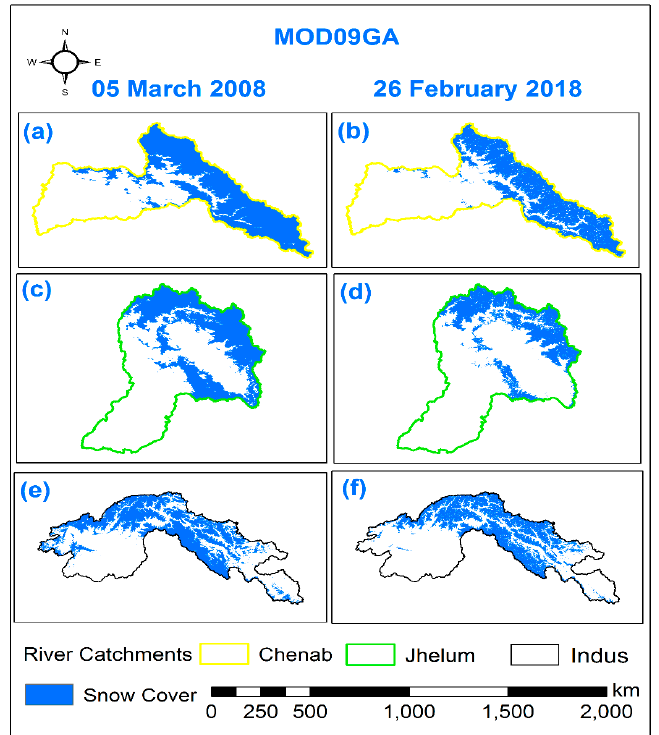
Figure 5. ( a – f ): Comparison of snow cover area delineated using MOD09GA product for 2008 and 2018 for the Chenab, Jhelum and Indus river catchment.